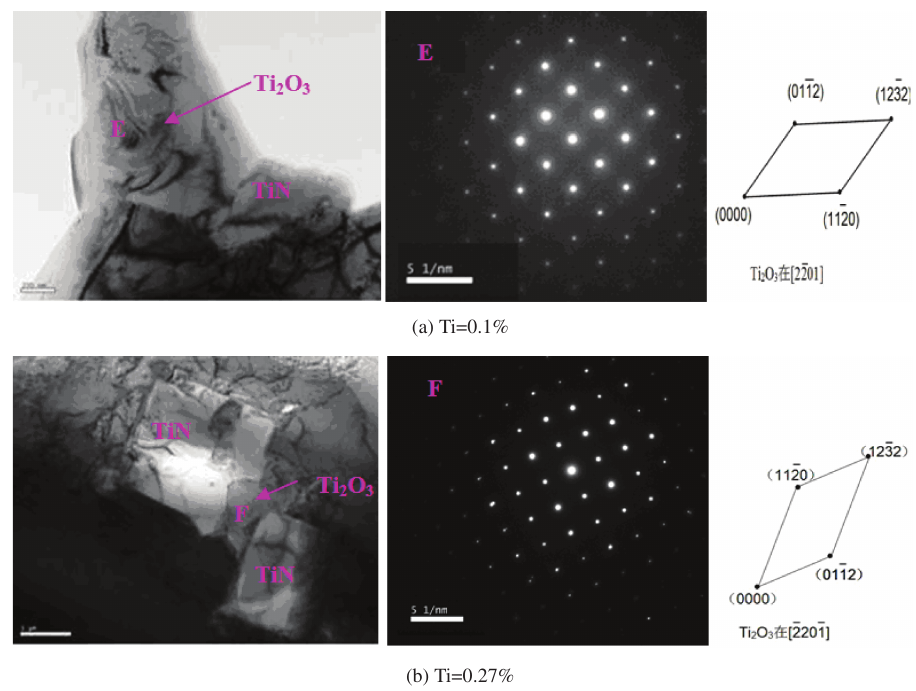
Figure 9: Morphology, electron diffraction patterns, and the indexing results of composite core-containing 0.1% and 0.27%